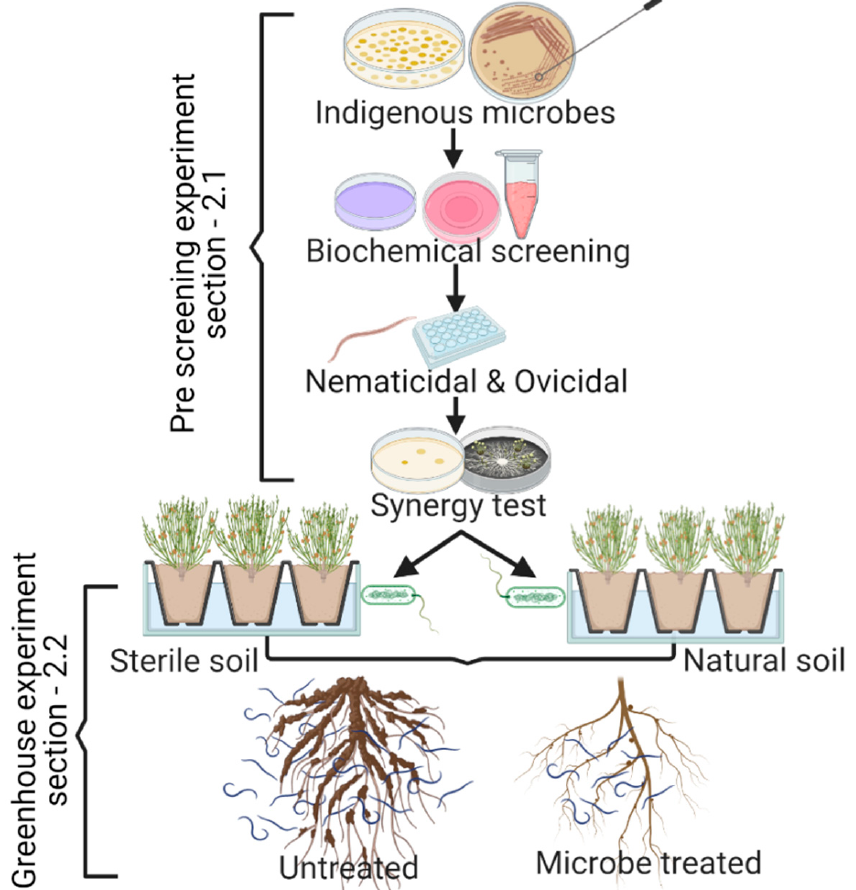
Figure 1. Schematic diagram of the microbial management of root knot nematode via indigenous microbes isolated from suppressive soils. The diagram shows the methodological steps we used in this study. In the first steps we isolated indigenous microbes, selected the most potent ones based on biochemical screening, and identified the gnomically. Then, in vitro nematicidal activity and synergy tests were done. In the second step we inoculated the selected microbes into the rhizosphere of basil plants in a greenhouse to examine the management of root knot nematode. The figure was created with the help of online illustration app BioRender.com.